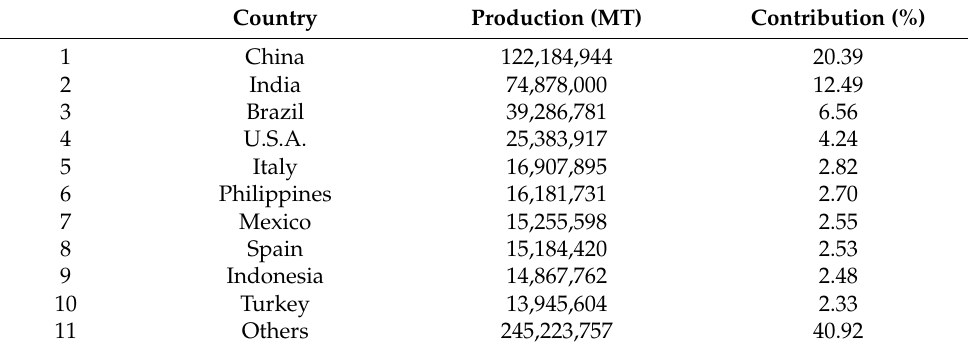
Table 3. Major fruit peel waste-producing countries. Adapted from Reference [71]. Copyright 2015, Walter de Gruyter GmbH.